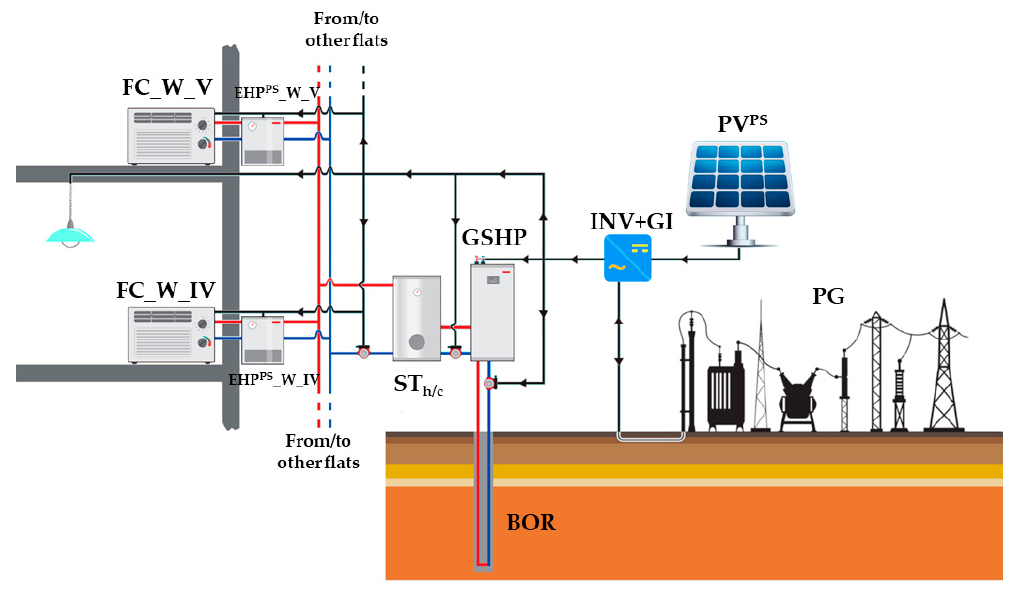
Figure 4. PS layout scheme. FC_W_V / FC_W_IV: fan-coil of flat W_V and W_IV; ST h / c : storage tank; EHP PS _W_V / EHP PS _W_IV: water to water electric heat pump of flat W_V and W_IV; PV PS : photovoltaic system; PG: power grid; INV + GI: inverter and grid interface; GSHP: ground source heat pump; BOR: boreholes.